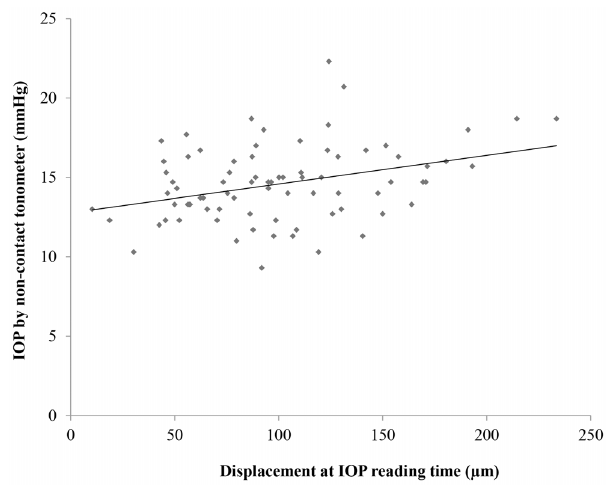
Figure 2. The relationship between the ocular surface dis- placement at the IOP reading time and IOP. The amount of ocular surface displacement at the IOP reading time showed a significant positive correlation with the IOP obtained using the non-contact tonometer (R 2 =0.1187, P =0.007).